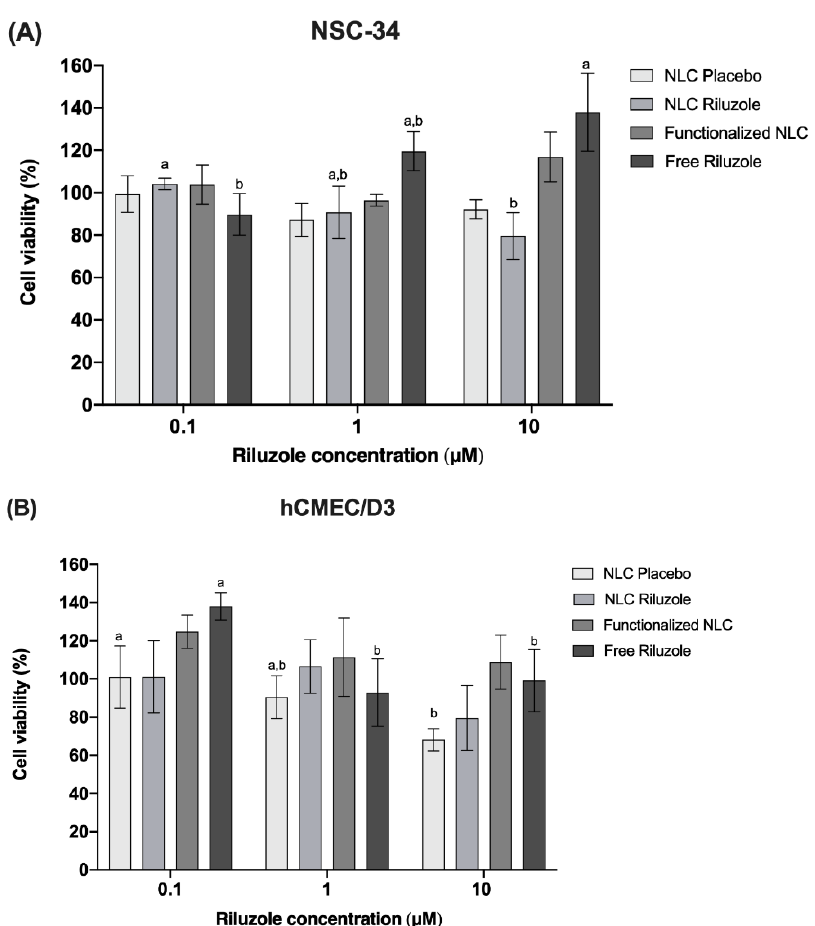
Figure 7. Effects of NLC Placebo, NLC Riluzole, functionalized NLC, and free riluzole exposure on the viability of NCS-34 ( A ) and hCMEC/D3 ( B ) cells at different concentrations (0.1–10 μM), as measured by the MTT assay. Values are expressed as mean ± SD ( n = 6). Different letters (a,b) mean significant differences between concentrations of the same sample ( p < 0.05) according to Tukey’s HSD test.